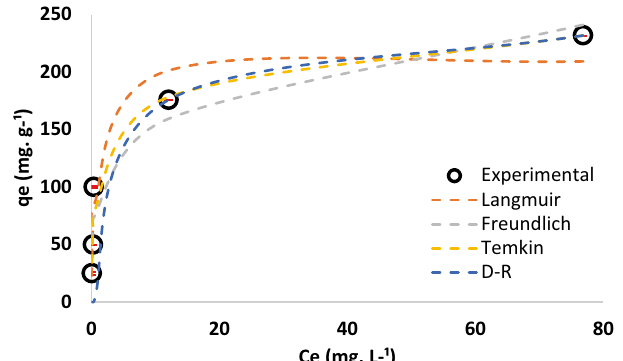
Figure 7. Comparison of equilibrium experimental data with the Langmuir, Freundlich, Temkin, and Dubinin–Radushkevich (D–R) models. (Contact time: 48 h; initial pH: 6.5; initial Cr(VI) concentration: 100 mg L −1 ; adsorbent dosage: 0.1–4 g L −1 ; and temperature: 25 °C).